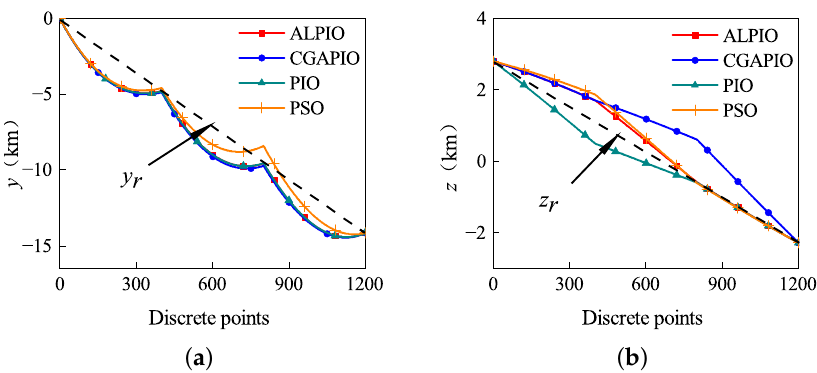
Figure 16. ( a ) Projection of the trajectory of Spacecraft 4 on the y r axis; ( b ) Projection of the trajectory of Spacecraft 4 on the z r axis.